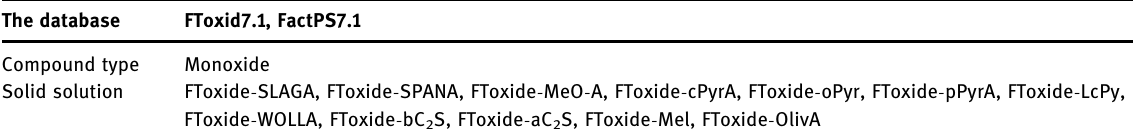
Table 9: FactSage7.1 parameter settings The database